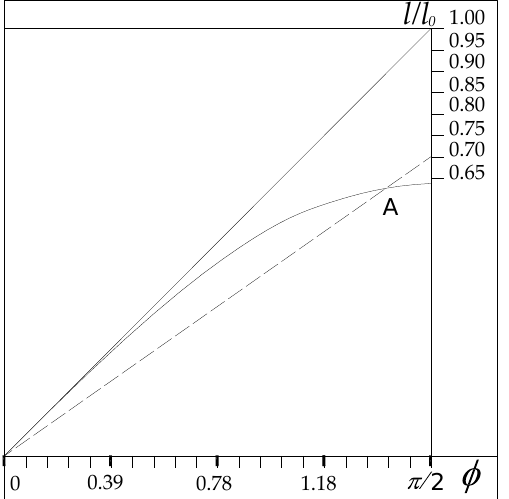
Figure 3. Useful graph to solve Equation (9) with respect to φ for a given value of the ratio l / l 0 . If, for example, the ratio l / l 0 is 0.7, one draws the line from origin to 0.7 on the vertical line. The abscissa of the intersection point between the drawn line and the sine function (A for the actual example) gives the value of φ solving Equation (9).